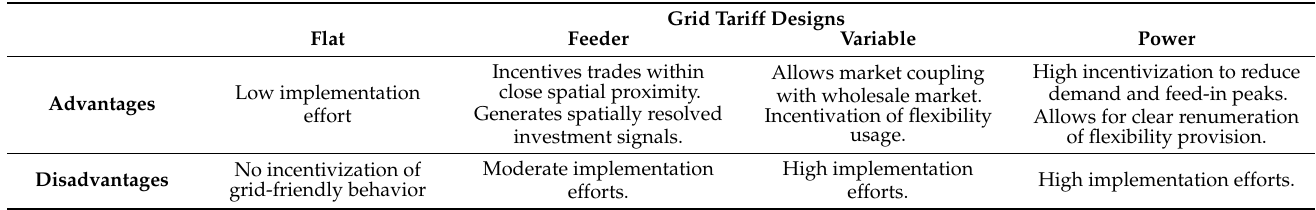
Table 3. Overview of potential advantages and disadvantages of proposed grid tariff